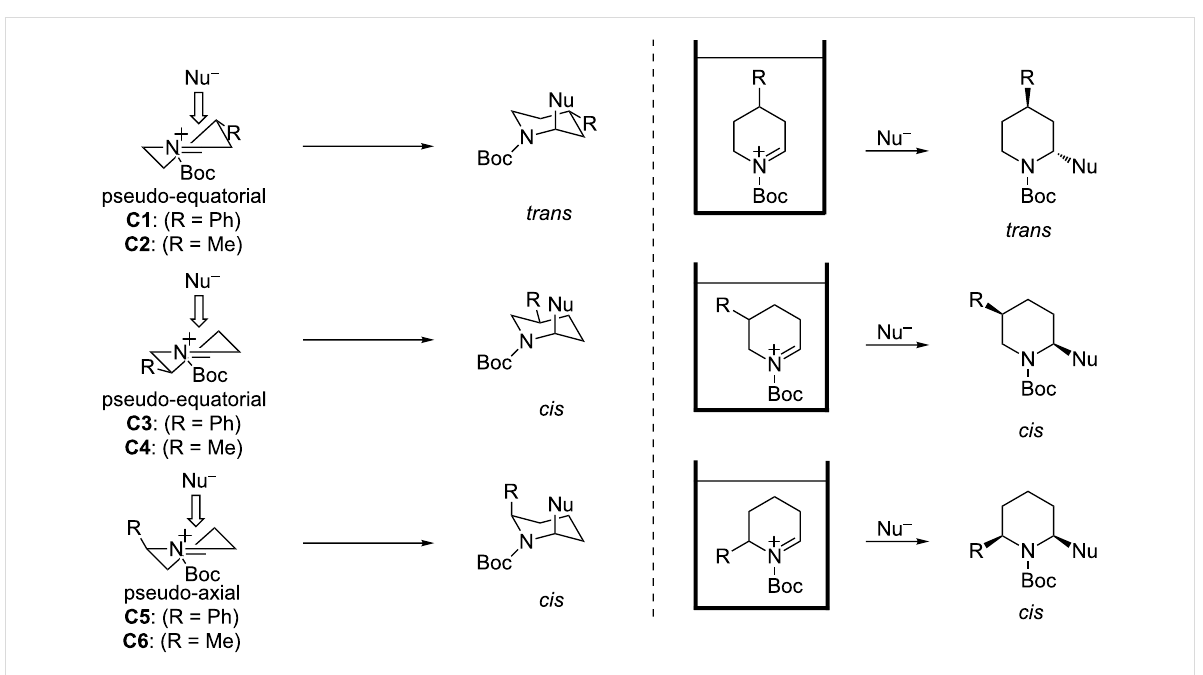
It is commonly assumed that the diastereoselectivity of the disubstituted piperidine derivatives 2a – f was influenced by the conformation of the N -acyliminium ions C1 – C6 . In this context Stevens proposed that the conformation of the six-membered